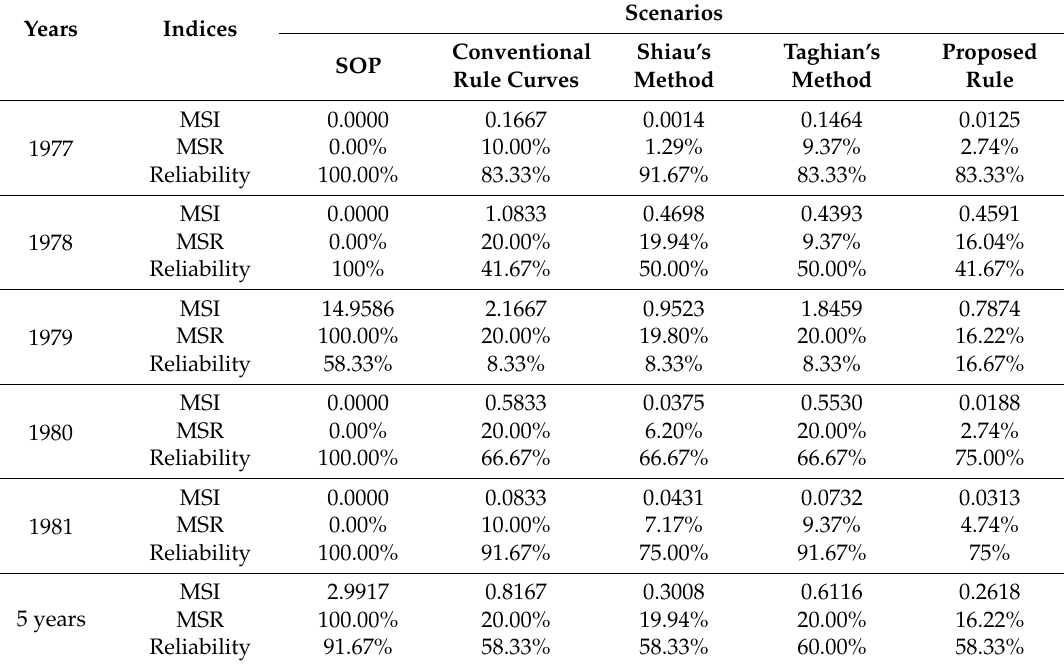
Table 4. The operation results of different scenarios during the critical periods.